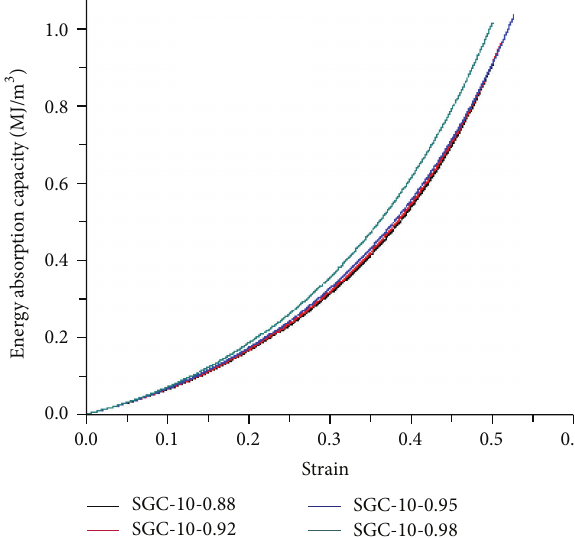
Figure 10: Compressive stress-strain curves at different compaction indices. Figure 11: Energy absorption capacity of the